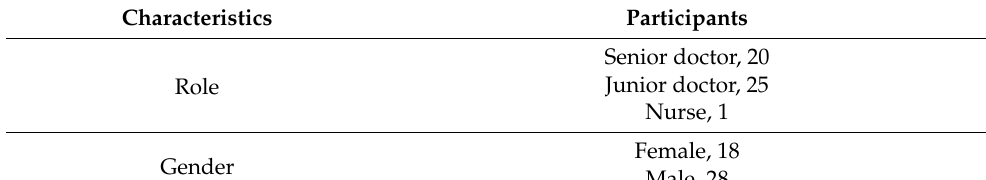
Table 1. Participant